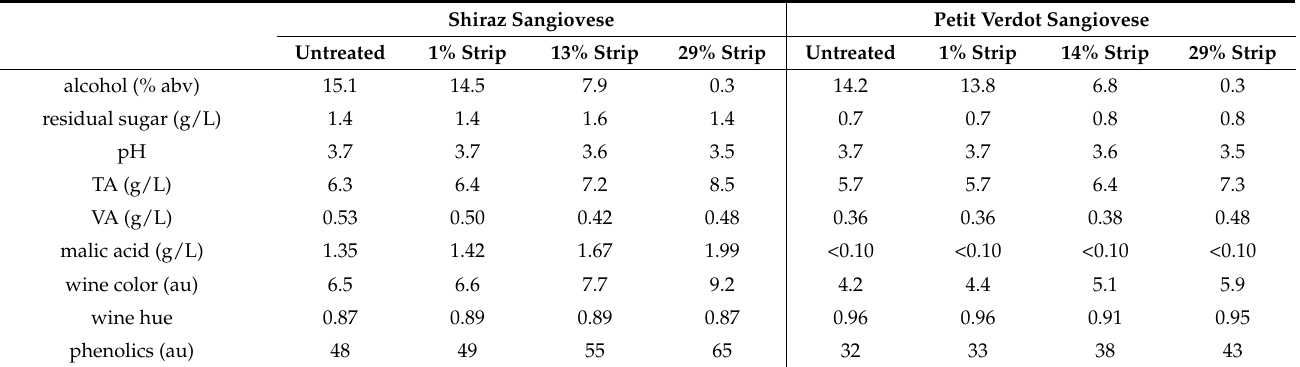
Table 1. Basic chemistry of smoke-tainted wines, before and after spinning cone column distilla- tion